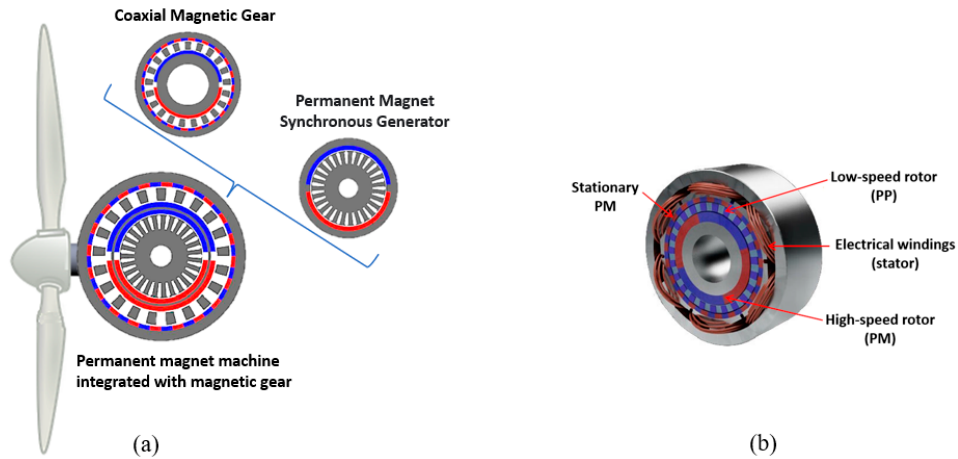
Figure 15. Powertrain configurations in a wind turbine using magnetic gear technology: ( a ) Perma- nent magnet machine integrated with magnetic gear [122]; ( b ) Pseudo-direct drive [127].